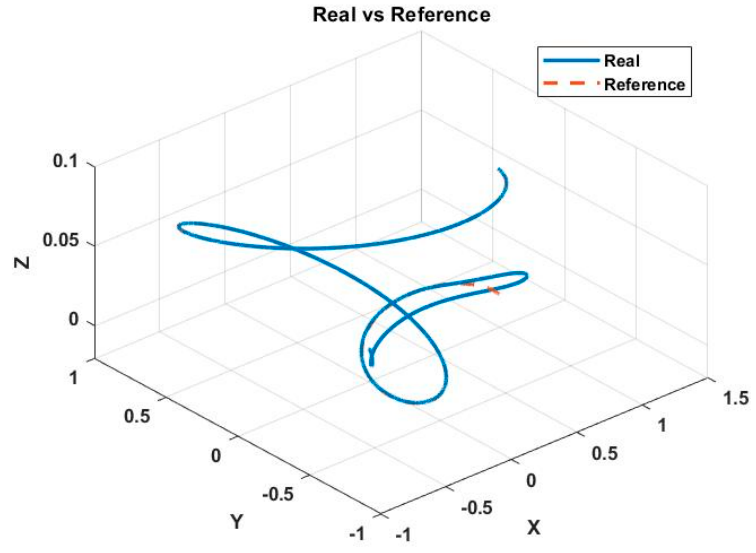
Figure 20. Tracking trajectory with PID.